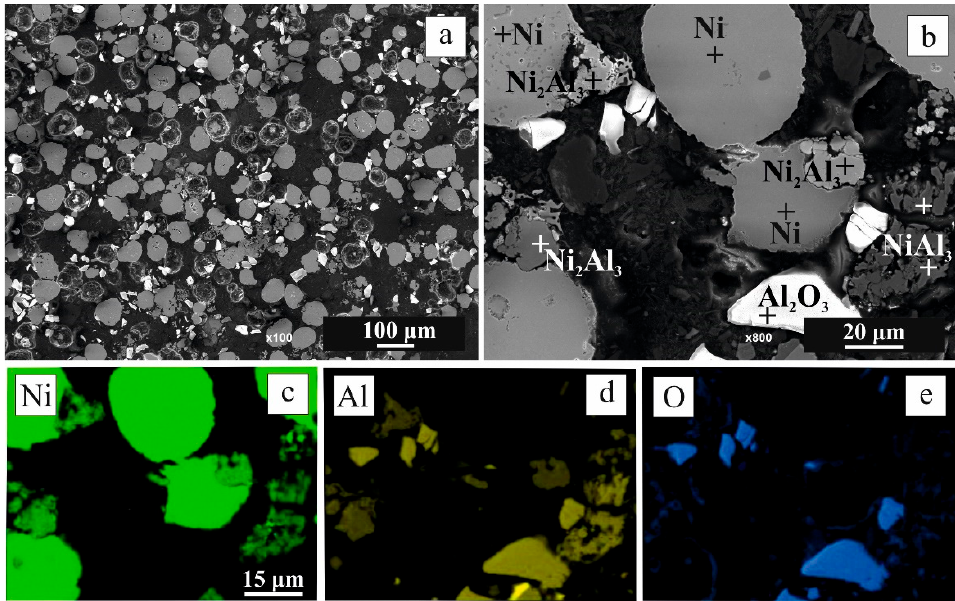
Figure 10. SEM-EDS images of the disintegrated crack mixture after annealing in Argon; macrostructure ( a ), corresponding detail in higher magnification with point elemental composition ( b ), and EDS elemental mapping, i.e., Ni ( c ), Al ( d ) and O ( e ).